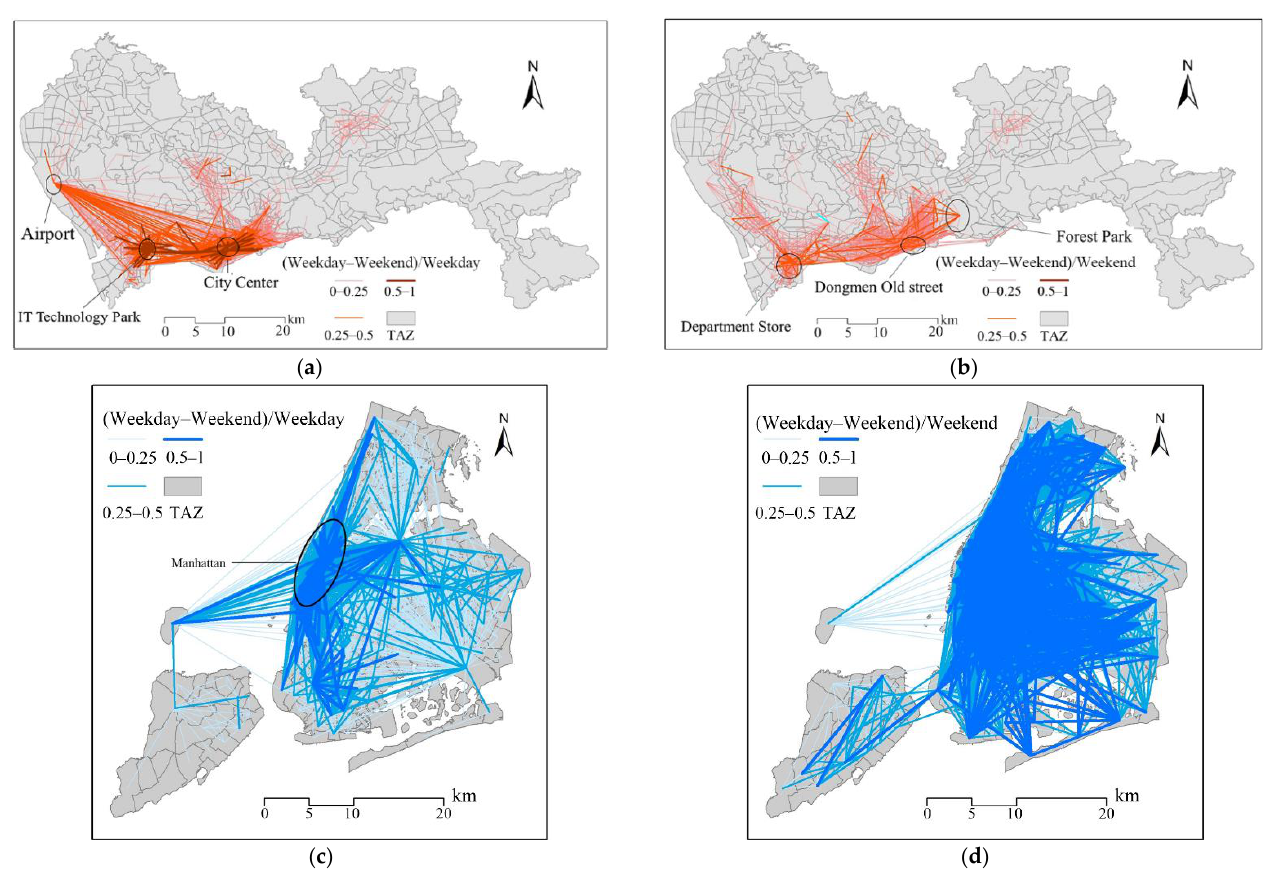
Figure 11. Normalized difference of OD distribution. ( a ) Normalized difference between weekday and weekend of OD distribution in Shenzhen. ( b ) Normalized difference between weekend and weekday of OD distribution in Shenzhen. ( c ) Normalized difference between weekday and weekend of OD distribution in New York. ( d ) Normalized difference between weekend and weekday of OD distribution in New York.